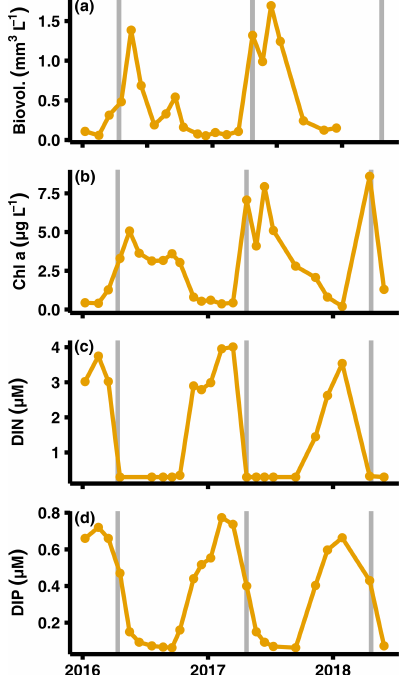
Figure A6. Primary production and nutrient monitoring data. Data from SMHI station BY15 at top 10m of the water column (SMHI, 2021). The graphs show (from a to d ) phytoplankton biovolume, chlorophyll a concentrations, DIN (nitrate + nitrite + ammonium) concentrations, and dissolved inorganic phosphorus (DIP) concentrations. The grey lines indicate when samplings for this study were